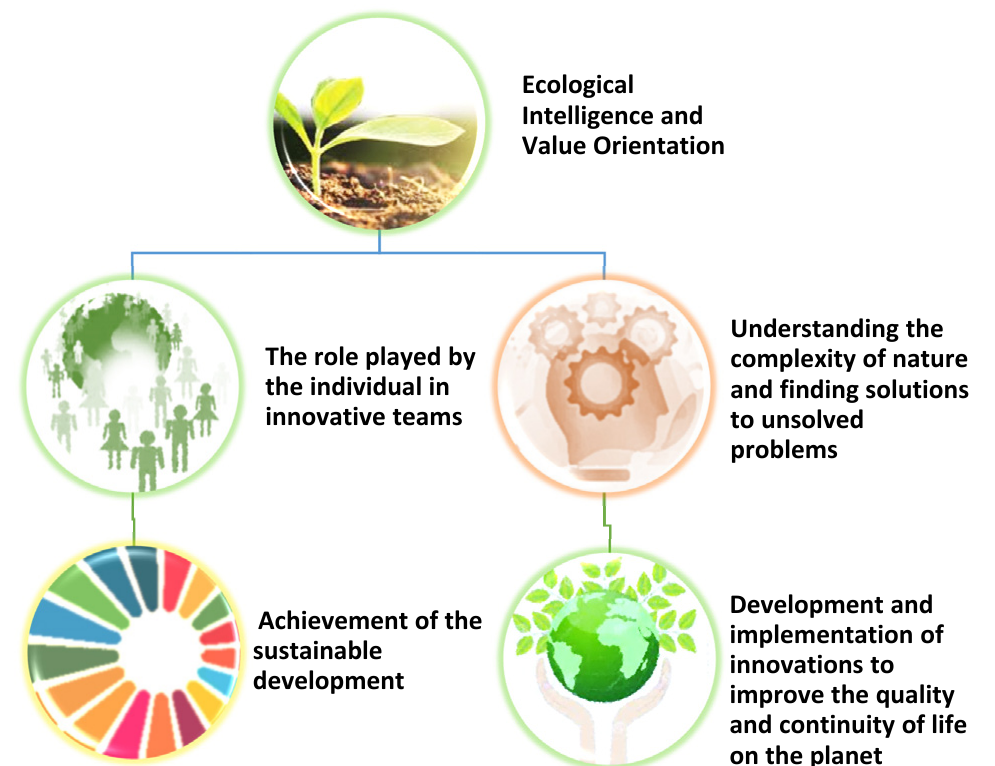
Fig. 1: The concept model illustrates the importance of EI and VO towards development and implementation of innovations in the achieve - ment of